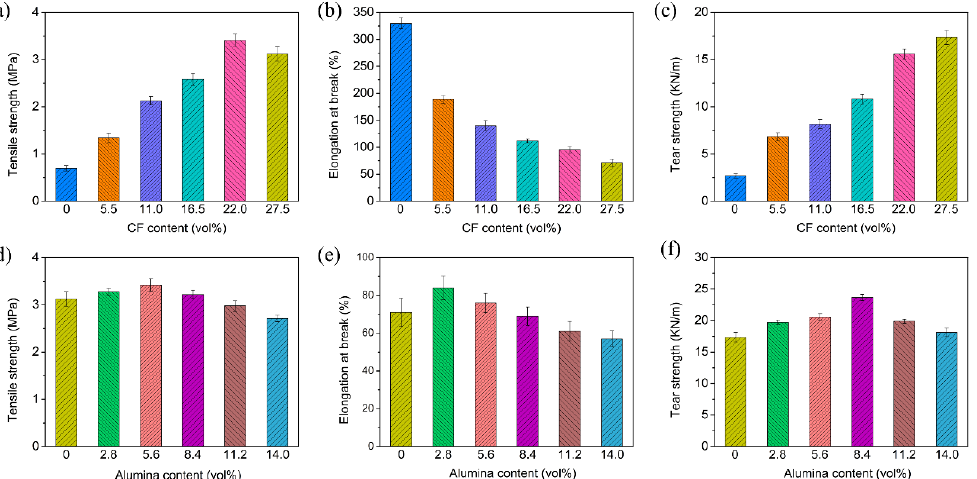
Figure 5. ( a – c ) The tensile strength, elongation at the break and tear strength of the PDMS/CF composites, respectively, ( d – f ) The tensile strength, elongation at the break and the tear strength of the PDMS/alumina/CF composites, respectively.